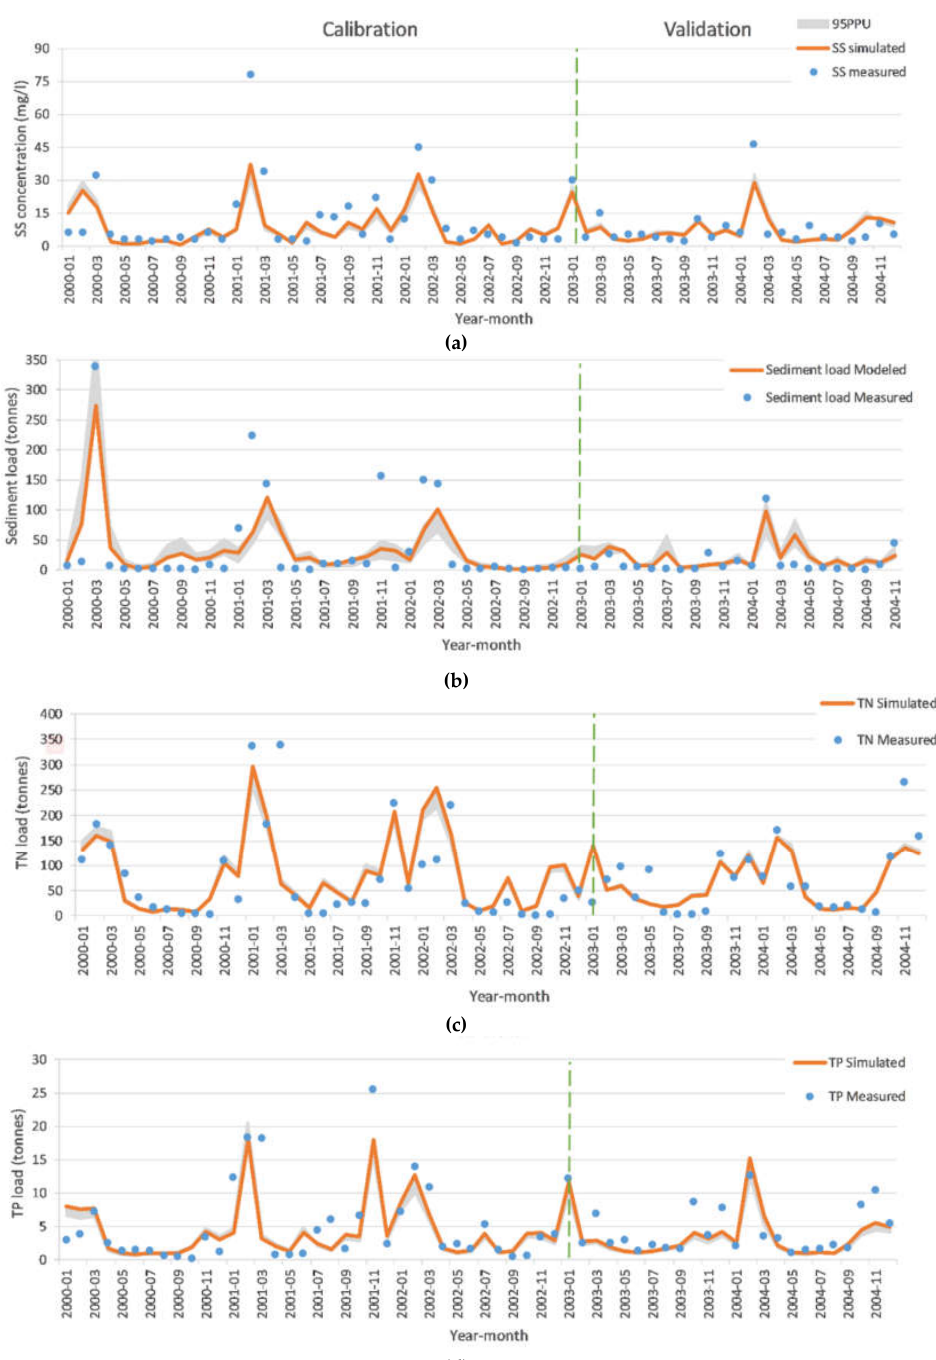
Figure 6. Measured and simulated suspended solids concentration ( a ), sediment load ( b ), total nitrogen load ( c ), and total phosphorus load ( d ) at the Minija—below Gargždai station for the calibration and validation periods.